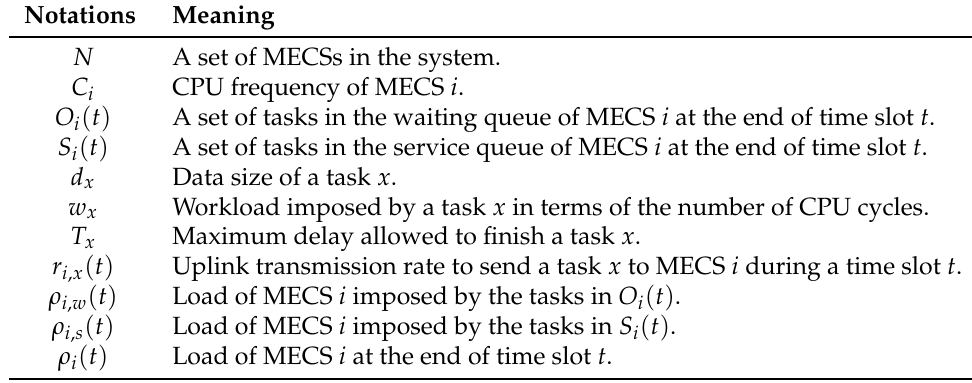
Table 1. Notations